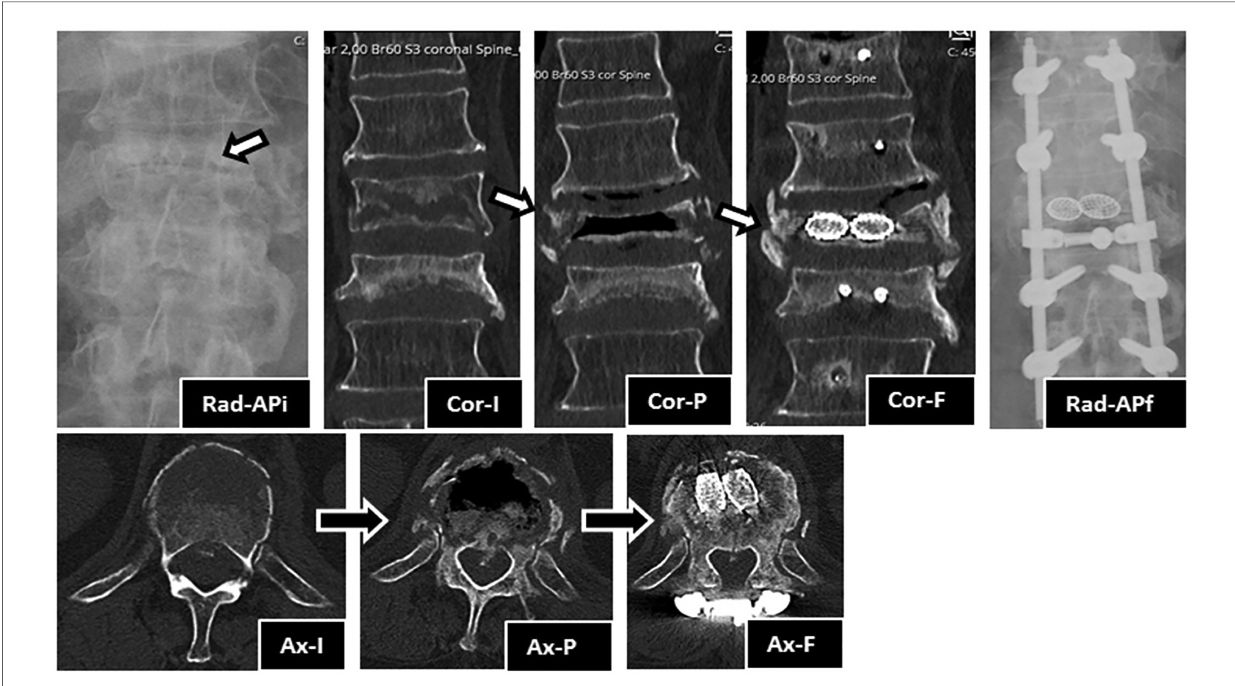
FIGURE 2 Imaging evolution of the clinical case in anteroposterior view radiography and coronal and axial CT sections: Rad-APi — initial radiograph in anteroposterior view, showing T12 and L1 vertebral body fl attening and extensive bone destruction (arrow) at T12; Cor-I — initial coronal view of CT, showing acute T12 fracture and old L1 fracture. Note the extensive bone trabeculae destruction across the entire width of the vertebral body; Cor- P — Coronal view of CT, showing T12 vertebral body pseudarthrosis with a large intravertebral cleft across the entire width and height of the vertebral body; Cor-F — Coronal view of CT at 1 year after surgery, showing T12 vertebral body pseudarthrosis cleft fi lled with stents with bone graft inside, which demonstrates signs of bone healing and osteointegration. Also note the development of lateral osteophytes that help to stabilize the vertebral body to the adjacent ones; Rad-APf — Final radiograph in anteroposterior view at 2 years after surgery, showing T12 stents, adjacent pedicle screws, rods and crosslink; Ax-I — Initial axial view of CT, showing acute T12 fracture. Note the extensive bone trabeculae destruction across the entire width of the anterior half of the vertebral body; Ax- P — Axial view of CT, showing T12 vertebral body pseudarthrosis with a large intravertebral cleft across the entire width of the anterior half of the vertebral body; Ax-F — Axial view of CT at 1 year after surgery, showing T12 vertebral body pseudarthrosis cleft fi lled with two stents with bone graft inside, which demonstrates signs of bone healing and osteointegration. Also note T12 laminectomy procedure, the crosslink applied at that level and the remodeling of posterior wall retropulsion with reabsorption of intracanalar